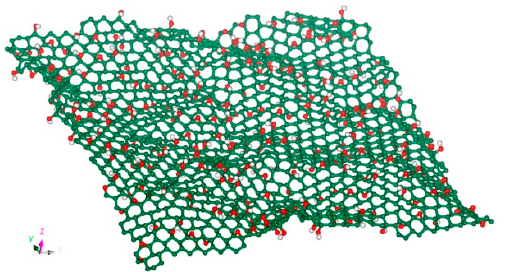
Figure 2. Model of polycrystalline graphene oxide after relaxation.